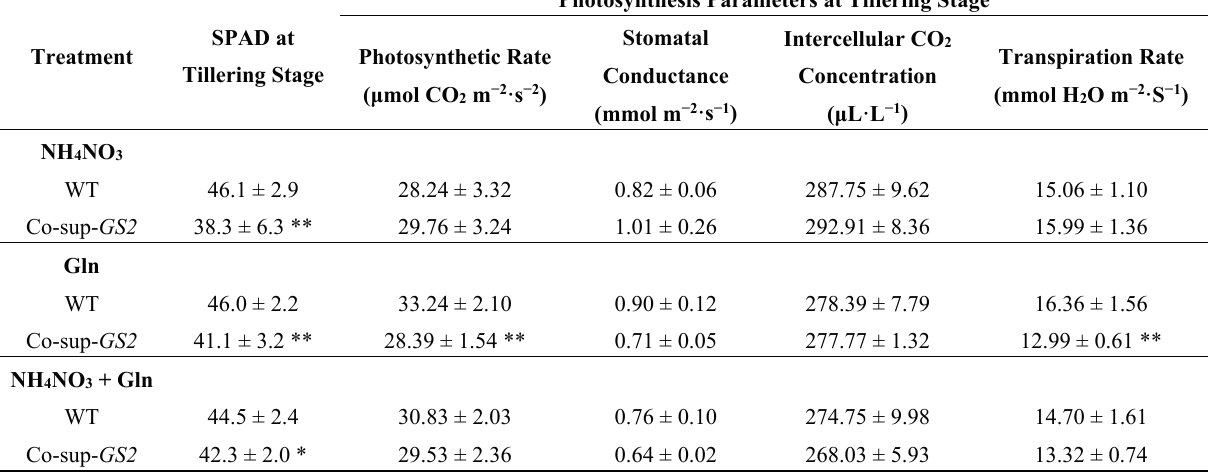
Table 1. The leaf SPAD value and photosynthetic parameters in the GS2 -cosuppressed plants (Co-sup- GS2 ) and wild-type plants (WT) at the tillering stage under N (NH 4 NO 3 ), G (Gln) and N + G (NH 4 NO 3 + Gln) conditions. SPAD Treatment